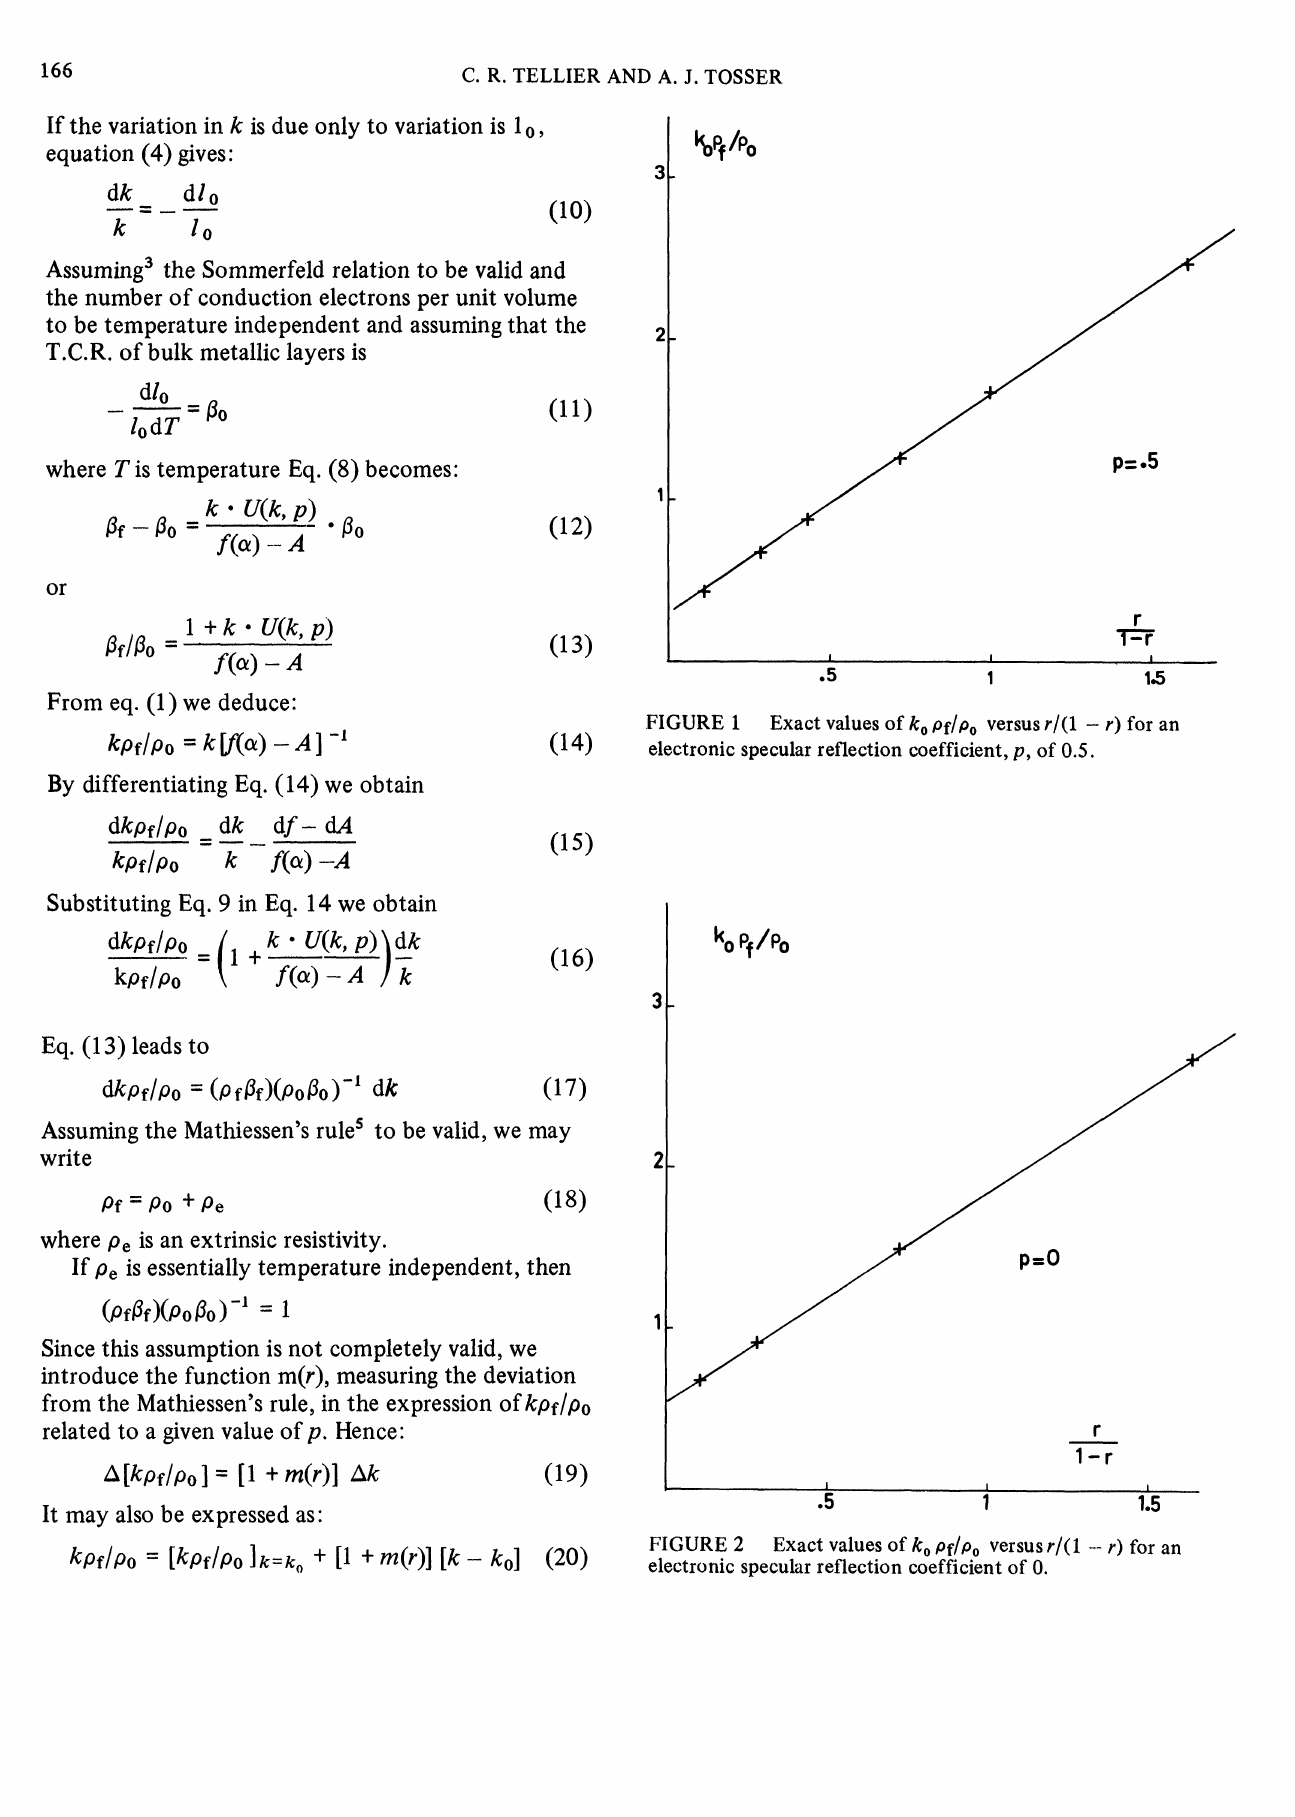
FIGURE 2 Exact values of k Pf/Po versus r/(1 r) for an electronic specular reflection coefficient of